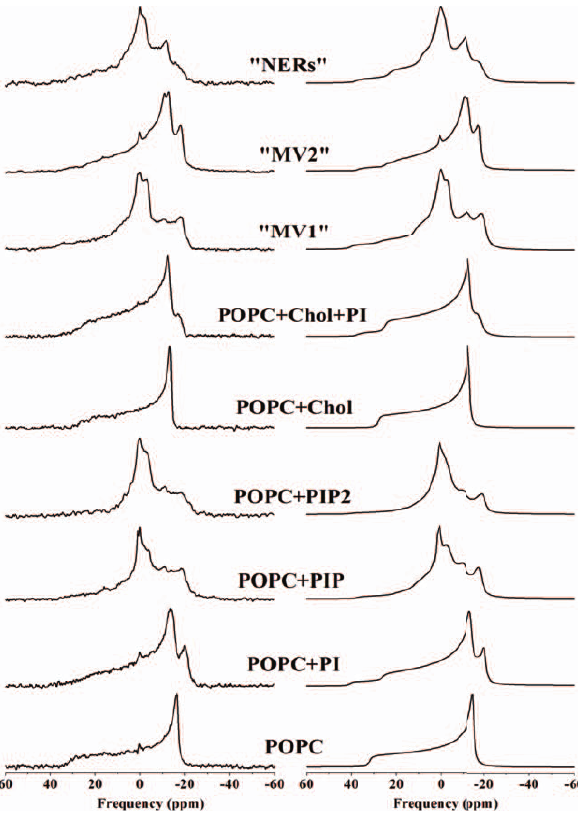
Figure 3. Orientational dynamics at the membrane surface determined by phosphorus-31 NMR spectra. Left Column: representative experimental wide-line phosphorus-31 NMR spectra of different model membranes containing POPC, PtdIns and cholesterol. The molar ratios are representative of the lipid composition found in MV1, MV2 and NERs, from bottoms to top: pure POPC, POPC/PtdIns (30/ 20), POPC/PtdInsP (30/18), POPC/PtdInsP 2 (30/12), POPC/Chol (58/42), POPC/Chol/PtdIns (28/42/30), ‘‘MV1’’: POPC/PtdIns/PtdInsP/PtdInsP 2 (30/20/18/12), ‘‘MV2’’: POPC/POPE/PtdIns/POPS (30/25/20/5) and NERs: POPC/Chol/PtdIns/PtdInsP/PtdInsP 2 (28/42/23/16/7/7). Temperature is 10 u C. Sample hydration (lipid mass/lipid + water mass) is 95%. Each spectrum is the result of 5 k cumulative scans. A Lorentzian filtering (LB) of 50–100 Hz was applied prior to Fourier transformation. Chemical shifts are expressed relative to 85% H 3 PO 4 (0 ppm). Right column: simulated spectra according to procedures described in text. Initial guesses, as measured on de-Paked spectra, of chemical shielding anisotropies, Ds , line widths, isotropic chemical shifts and relative weights of each subspectrum were supplied to the simulation procedure and iterative changes were performed until the best fit of experimental spectra was obtained. Ds and isotropic chemical shifts are reported in Table 3.